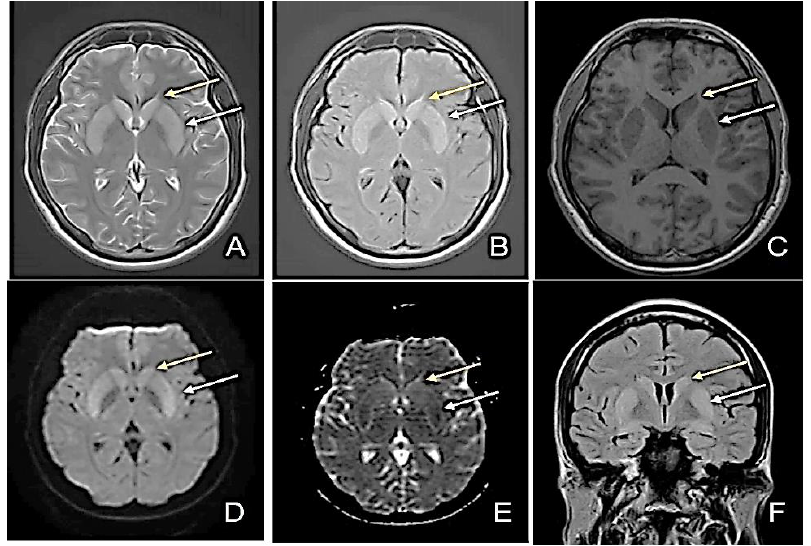
Figure 1. First Magnetic Resonance Imaging (MRI) — day 1 at the admission to our clinic (D1). ( A ) Axial T2-weighted image sequence: slightly increased bilateral putaminal and caudate nucleus sig- nal; ( B ) Axial FLAIR sequence: increased bilateral putaminal and caudate nucleus signal; ( C ) Axial T1-weighted image sequence: slightly decreased bilateral putaminal and caudate nucleus signal; ( D ) Diffusion-weighted image sequence (DWI); ( E ) Apparent diffusion coefficient map (ADC): mod- erate bilateral putaminal restricted diffusion; ( F ) Coronal FLAIR image: slightly increased bilateral putaminal (white arrow) and caudate nucleus signal (yellow arrow).